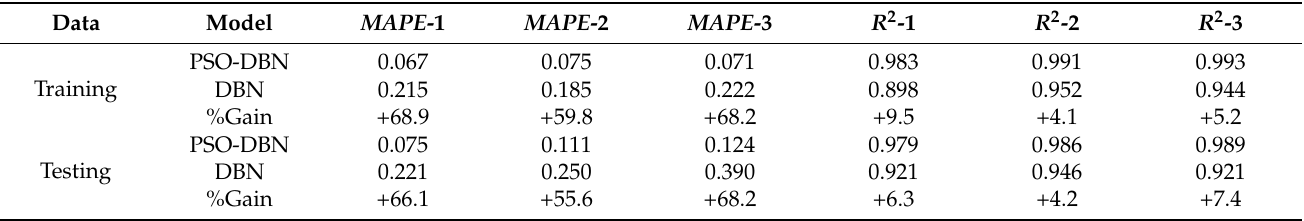
Table 7. Comparison of evaluation metrics between PSO-DBN model and single DBN model